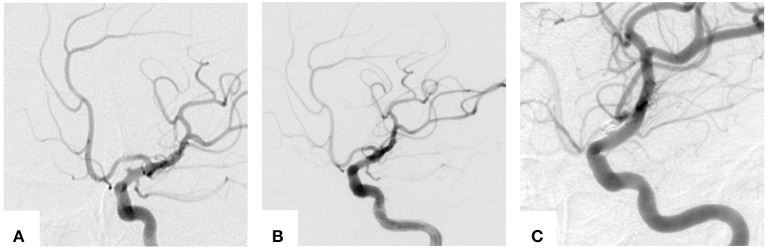
Images of the typical cases. (A) Cerebral angiograms obtained immediately pre-, (B) post-treatment and (C) 10-month follow-up DSA.